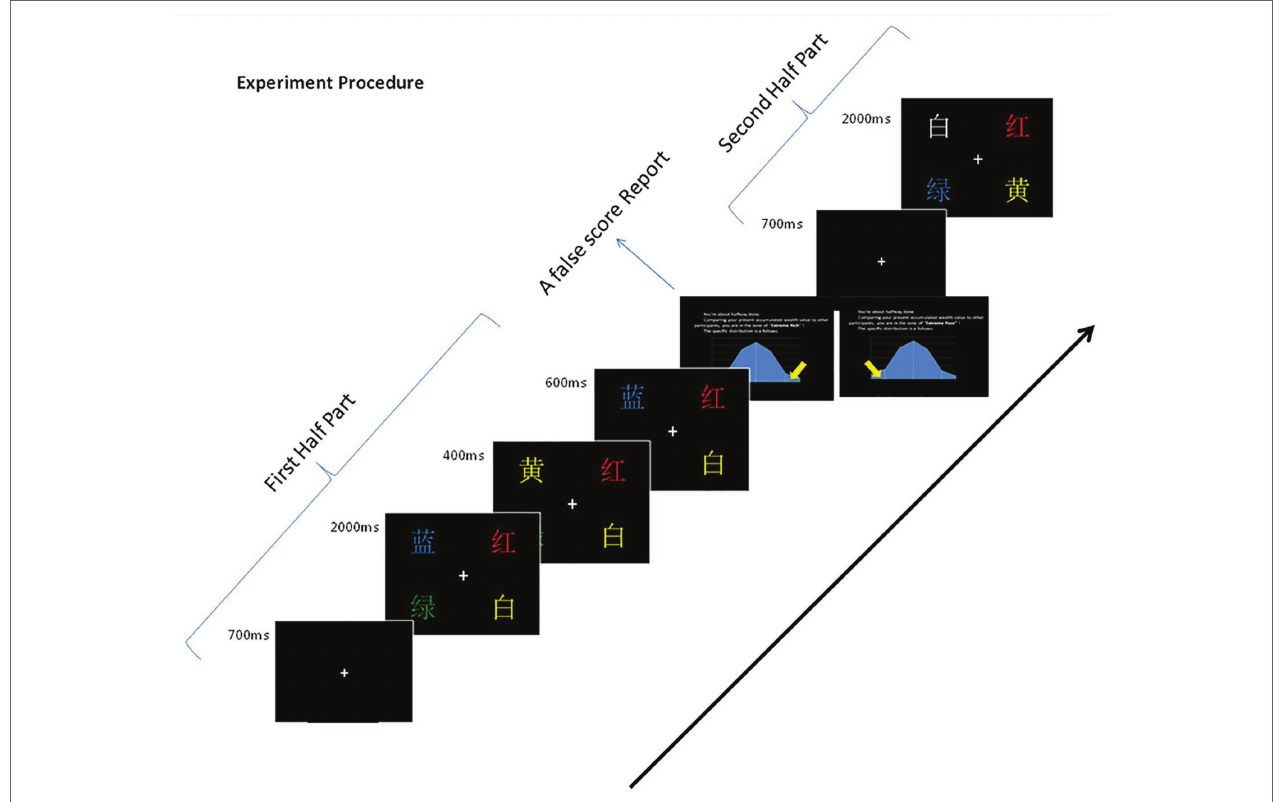
FIGURE 3 | Sample of the Stroop task trial